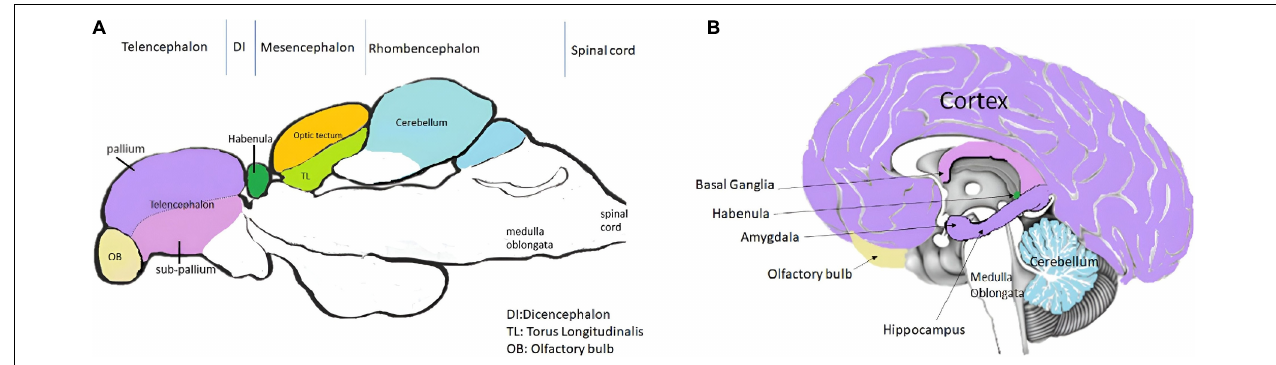
FIGURE 1 | Comparison of panel (A) (a representative of the mid-sagittal section of zebrafish brain) with (B) (a representative of mid-sagittal section of human brain). The figure attempts to represent the important areas involved in learning and memory in humans and zebrafish (Bally-Cuif and Vernier, 2010; Kozol et al., 2016; Langova et al.,